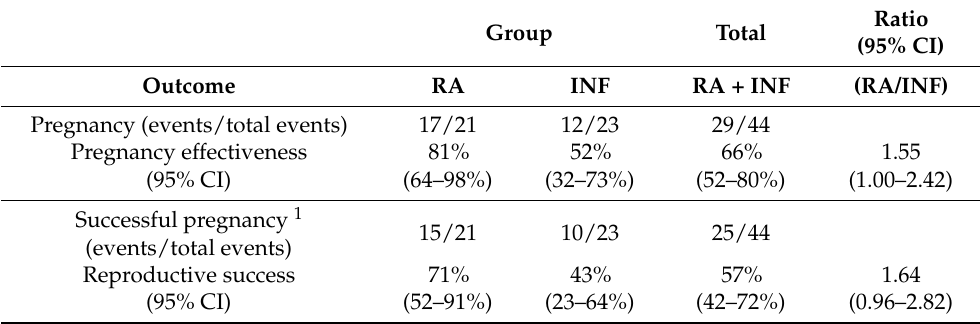
Table 4. Main outcomes after the probiotic treatment with L. salivarius CECT5713 in women with repetitive abortion (RA) and women with infertility of unknown origin